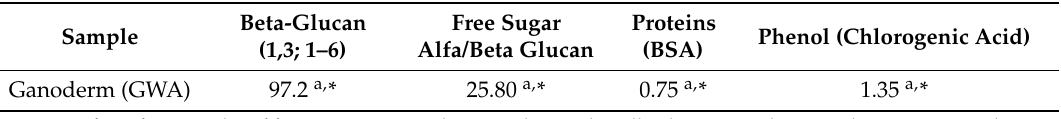
Table 1. Concentration of beta-glucan, free sugar, proteins and phenols (mg/1 g mushroom) in extract of Ganoderma lucidum.